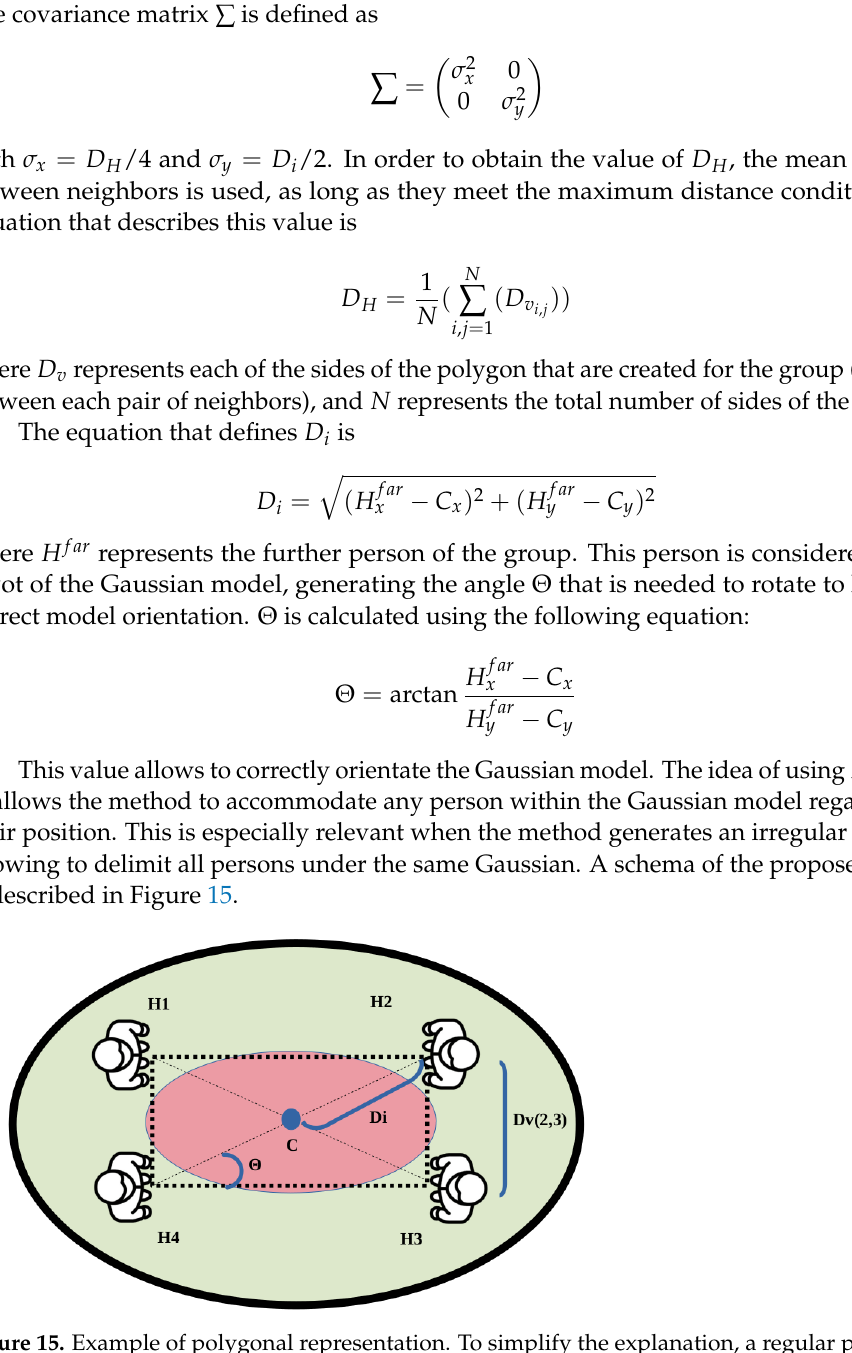
Figure 15. Example of polygonal representation. To simplify the explanation, a regular polygon is described. The same color scheme as in Figure 12 has been